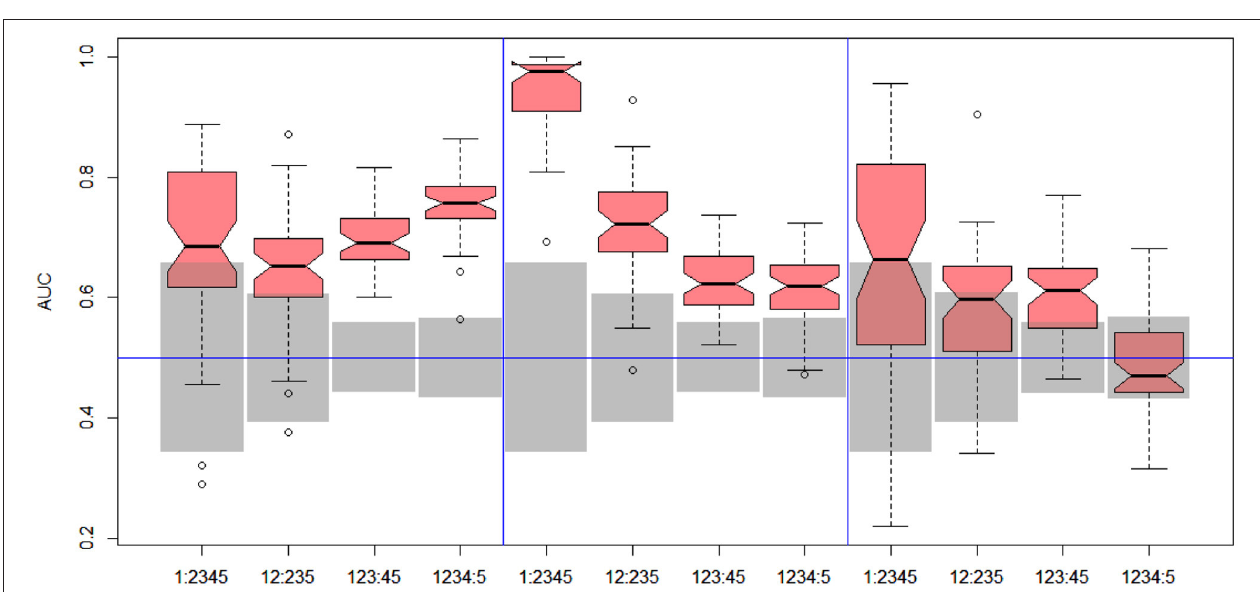
FIGURE 6 | DILI4 scanning results for A375, HEPG2, and MCF7 cell lines. Gray boxes correspond to 95% confidence interval for the null hypothesis.